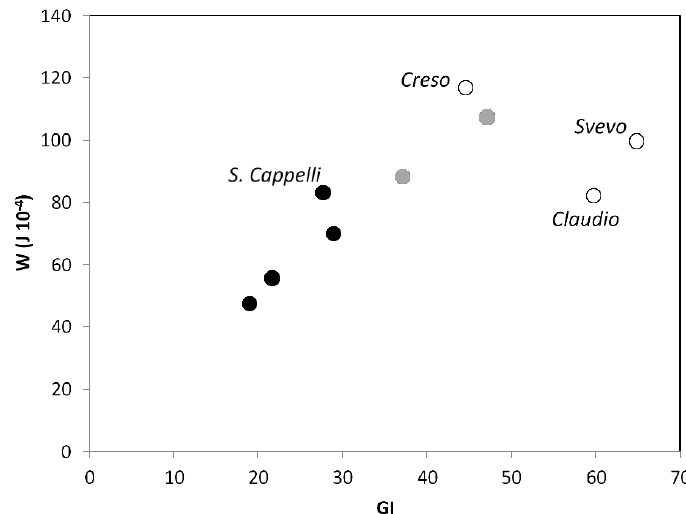
Figure 2. Relationship between gluten index (GI) and the alveographic index for gluten strength W.